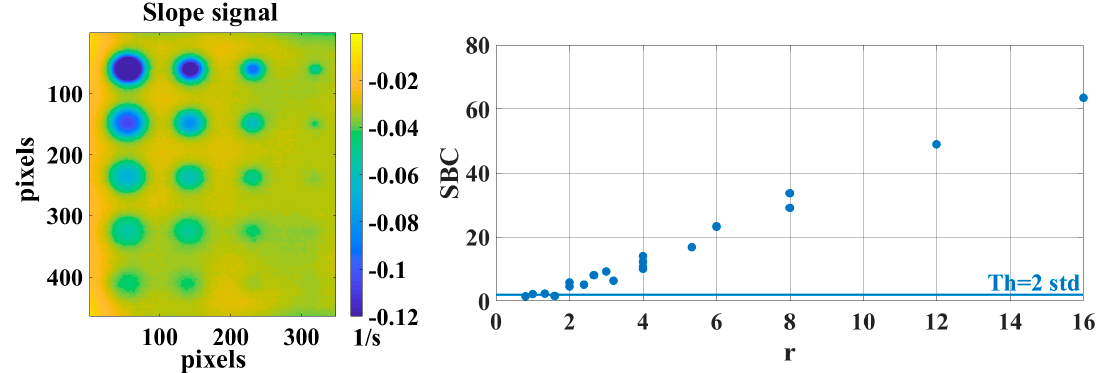
Figure 9. The Signal to Background Contrast (SBC) trend versus the ratio r in the case of slope algorithm by computing 1024 frames; the influence of the threshold value on the defect detectability.